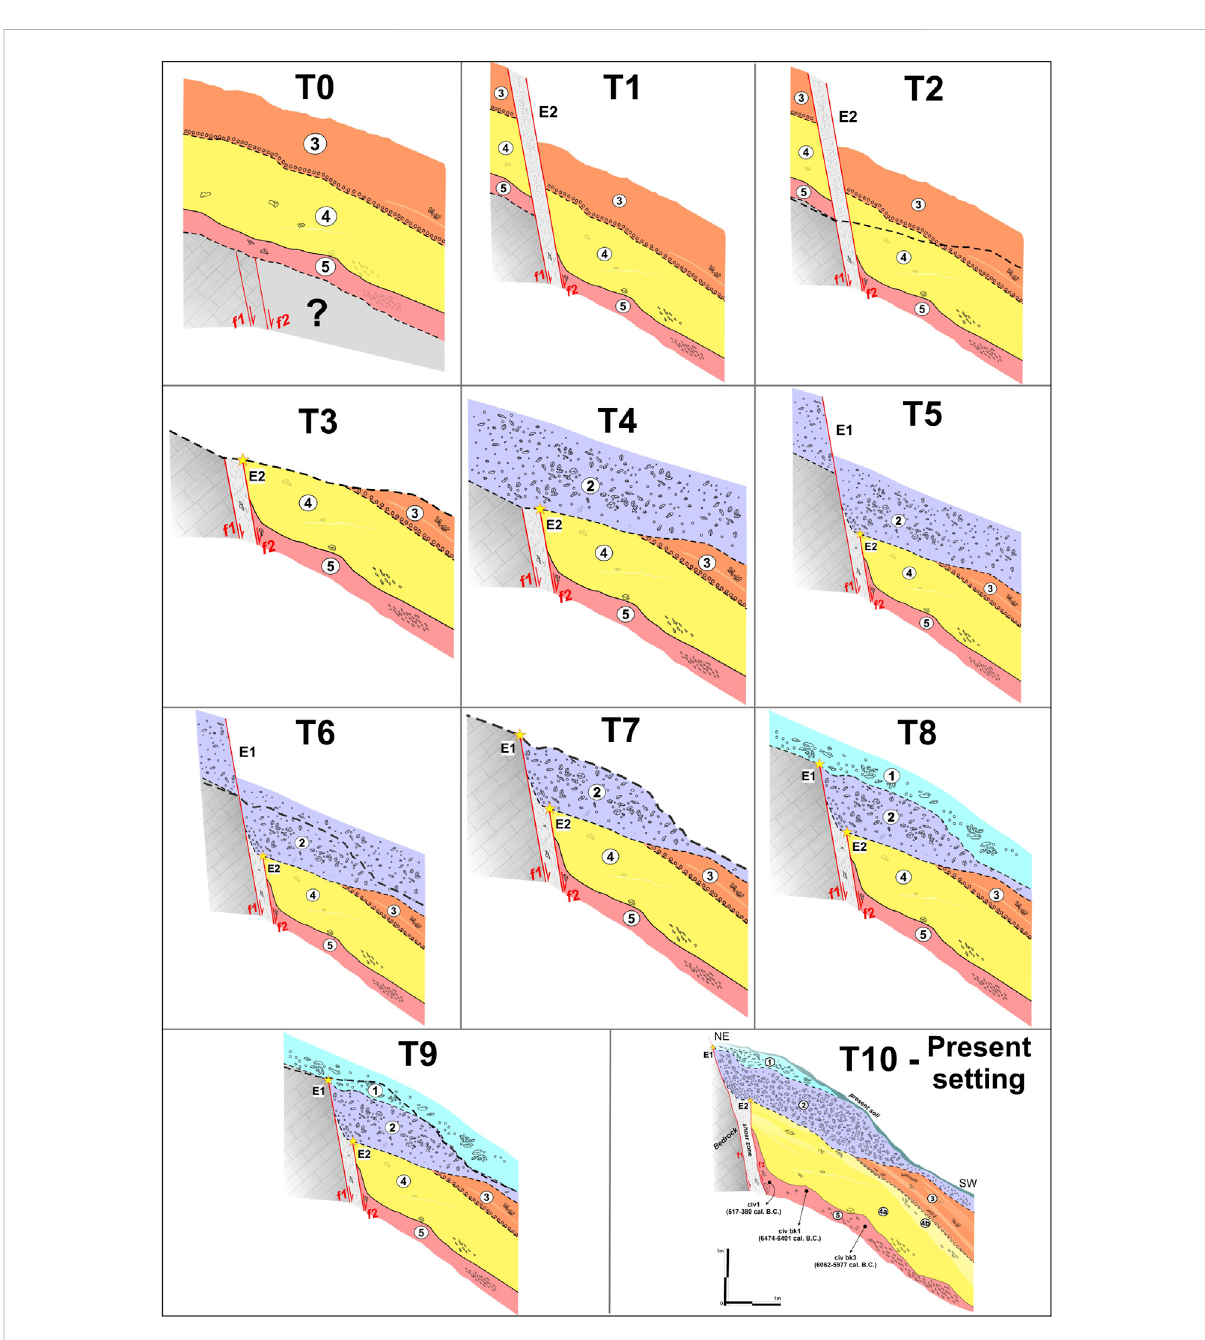
FIGURE 14 Palinspastic restoration of the tectonosedimentary evolution of the “ Grotta di San Bartolomeo ” excavation as derived from the analysis of the excavation wall. The different erosional, depositional, and faulting events are shown starting from the oldest (T0) to the youngest (T10).